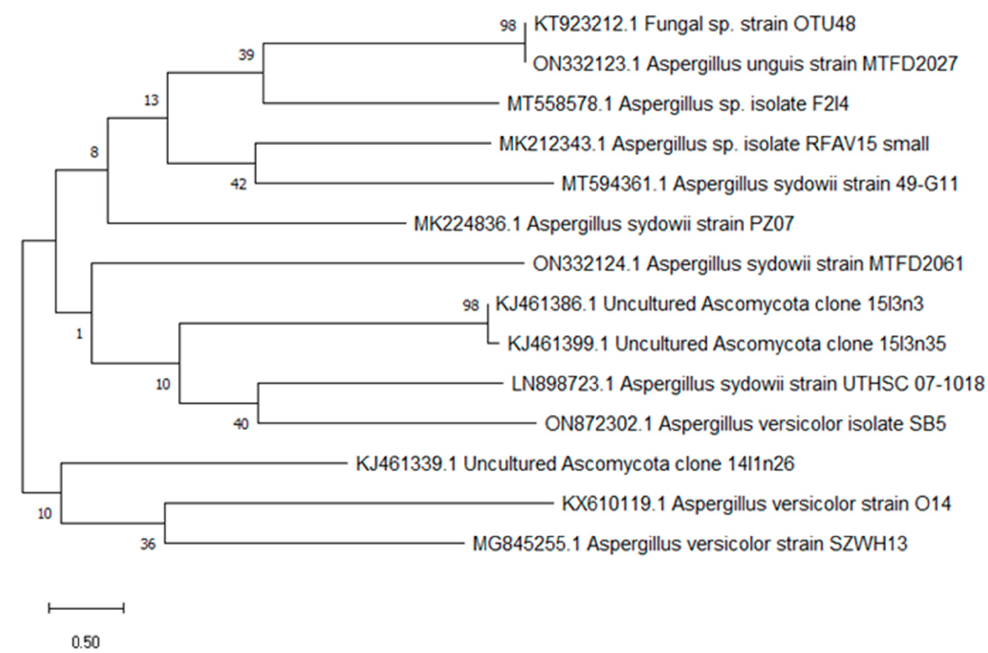
Figure 2. Constructed phylogenetic tree of Aspergillus versicolor SB5 .